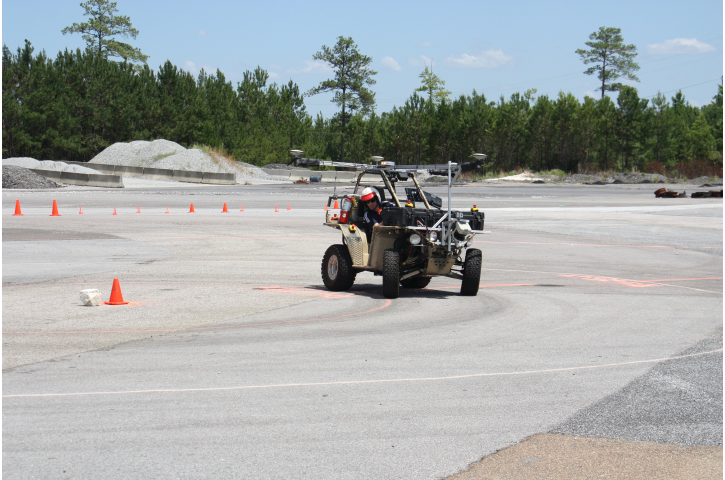
Figure 17. Tire relaxation and asymmetrical